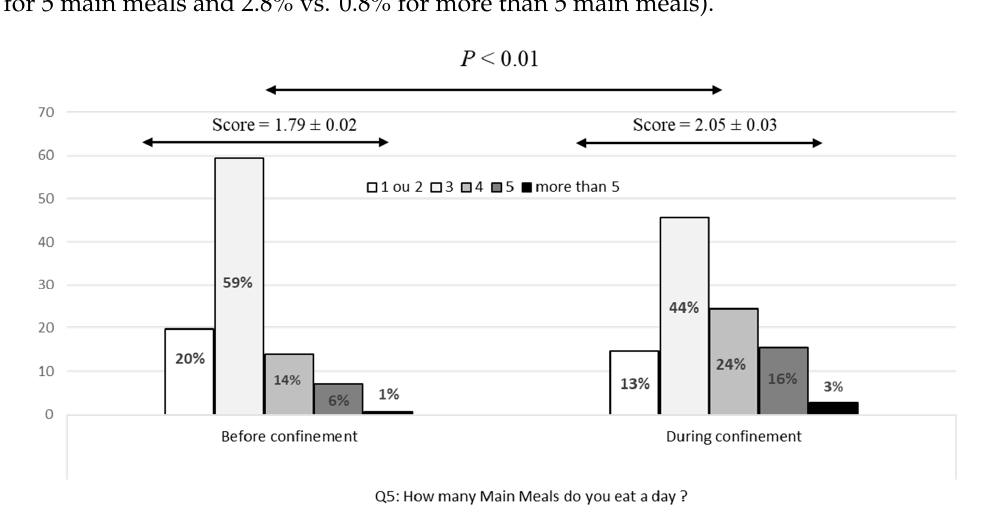
Figure 2. Response distribution (in %) and recorded score according to the number of main meals per day before and during confinement.